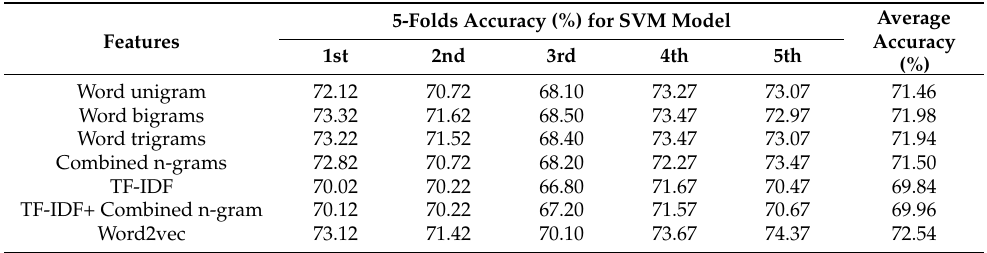
Table 8. NB models’ accuracy scores on each feature using binary class the dataset. Features